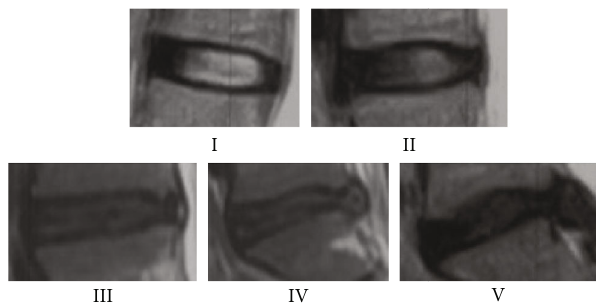
Figure 1: The degree of IVDD is evaluated by the P fi rrmann grade system. The discs with P fi rrmann grades I or II are nondegenerative discs, and the discs with grades III, IV, and V are taken as degenerative